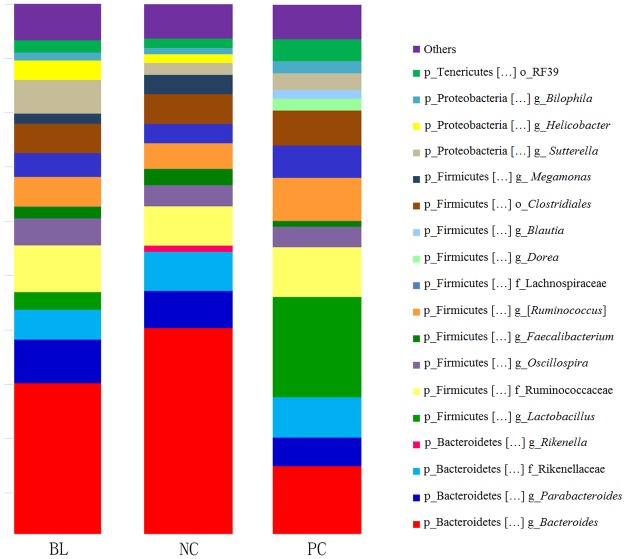
Cecal microbial composition of chickens with C. perfringens, Eimeria challenge and fishmeal supplementation.The 15 most abundant taxa in each group are shown to the phylum or genus level. Sequences that could not be classified at the genus level were labeled with the next highest level. NC, negative control; PC, treated with C. perfringens, coccidia, and fishmeal; BL, pre-treated with B. licheniformis then treated with C. perfringens, coccidia, and fishmeal.